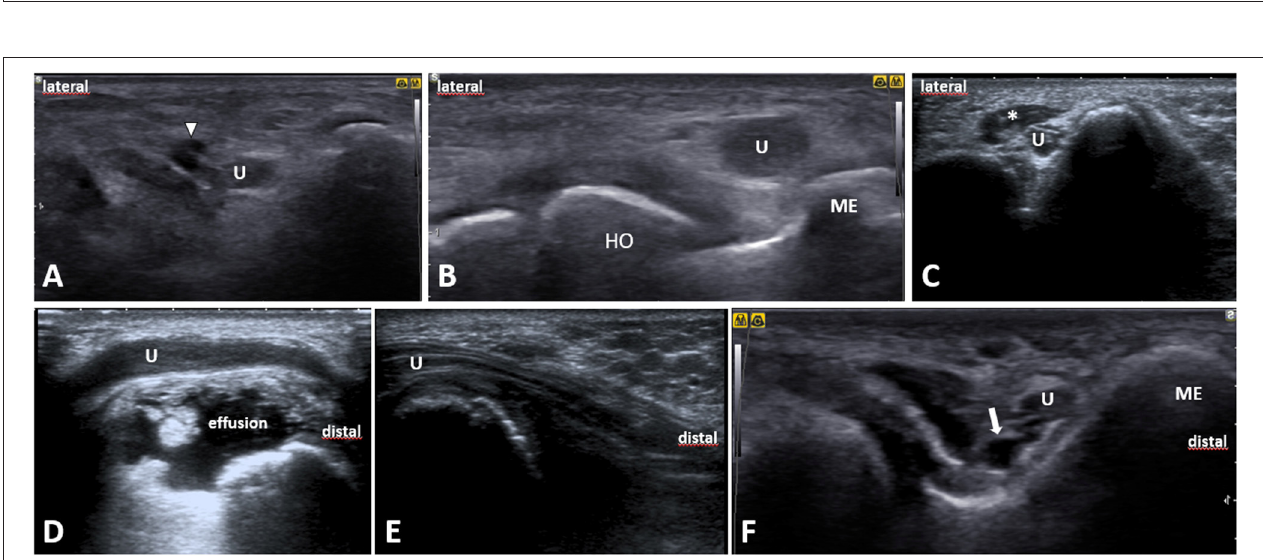
FIGURE 9 | Ultrasound images of the ulnar nerve exemplary pathologies. (A) Short-axis image at the level of the humeral medial epicondyle ( ME ) shows the ulnar nerve ( U ) in an intimate contact with a ganglion ( white arrowhead ), likely derived from the triceps tendon. (B) A short-axis US image of the ulnar nerve situated just next to the heterotopic ossification ( HO ). (C) The ulnar nerve short-axis image shows an accessory anconeus epitrochlearis muscle ( asterisk ). (D) A longitudinal US image of the post-traumatic degenerative joint disease with effusion compressing the ulnar nerve. (E) A longitudinal image of the ulnar nerve depicts the nerve compression from scar tissue after olecranon surgery. (F) A short-axis view at the ulnar nerve ( U ) shows an aberrant vein ( white arrow ) next to it. ME, medial epicondyle of humerus; U, ulnar nerve.